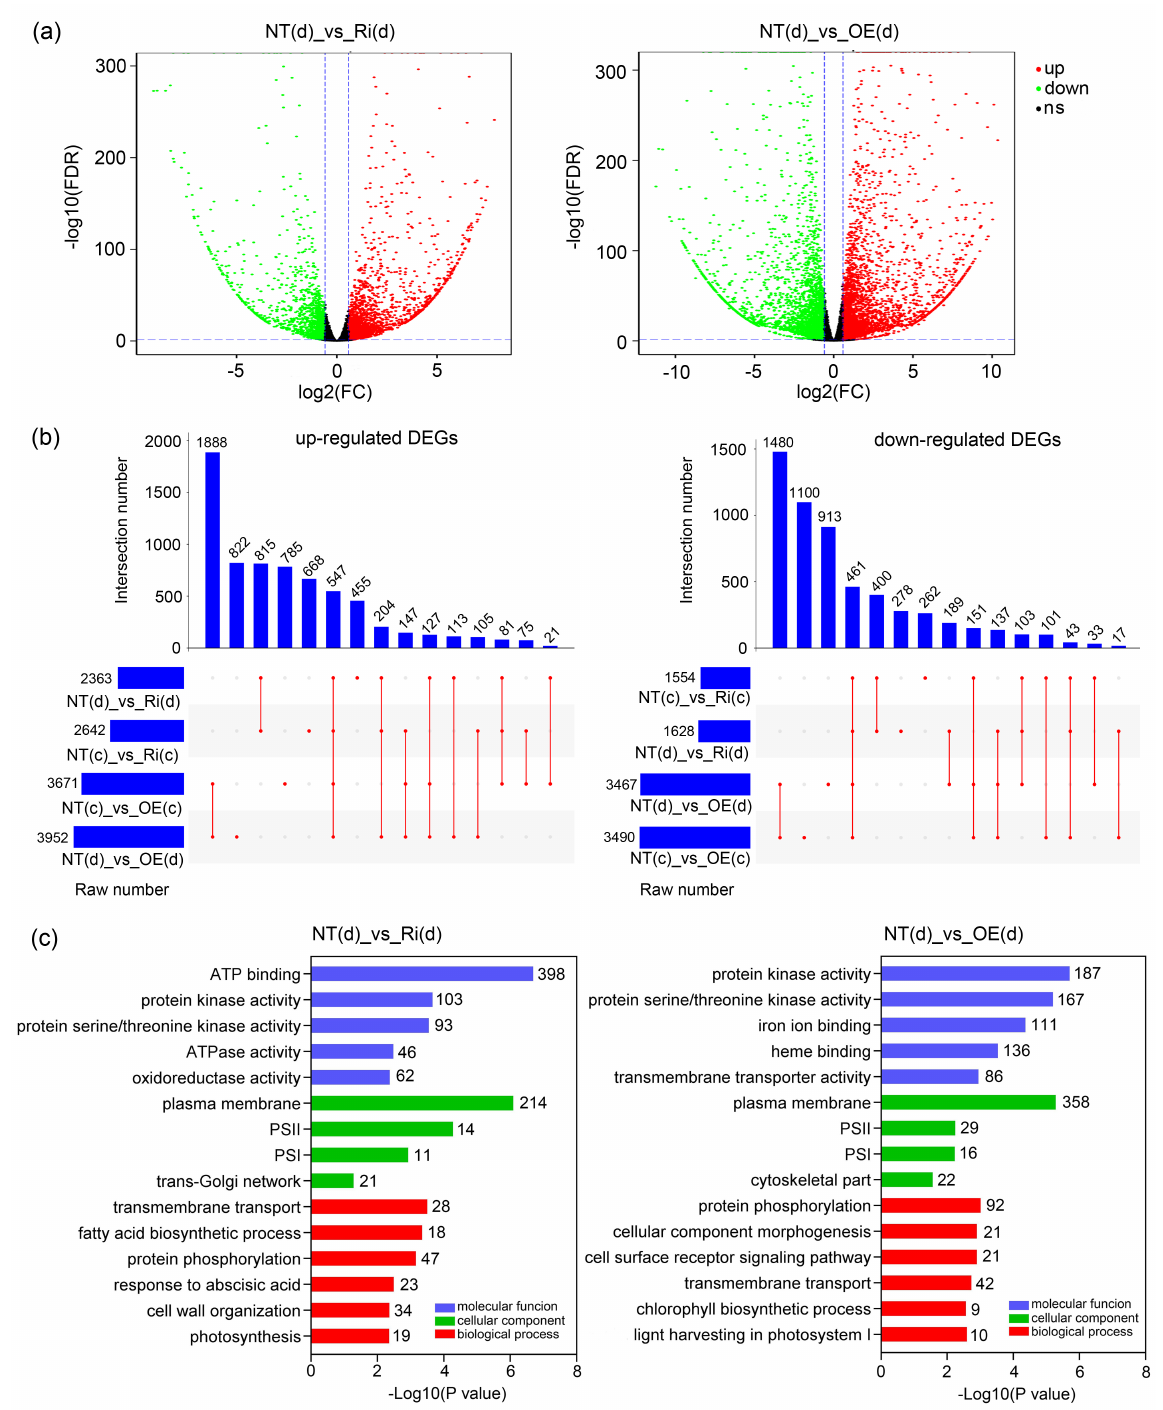
Figure 7. Comparison of RNA-seq data between NT and Ri or OE lines of maize seedlings under drought stress. ( a ) Volcano plots showing the number of differentially expressed genes (DEGs). Each point represents a DEG; ( b ) UpSet graphs displaying shared and unique DEGs identified in maize seedlings; ( c ) Gene Ontology (GO) functional annotation of molecular functions (blue column), cellular components (green column), biological processes (red column) of DEGs (numbers above each bar represent the number of DEGs related to the GO term). FC, fold change; NT(c), Ri(c), OE(c): seedlings of NT, Ri, OE under control condition, respectively; NT(d), Ri(d), OE(d): seedlings of NT, Ri, OE under drought condition, respectively. Up, up-regulated; down, down-regulated; ns, not